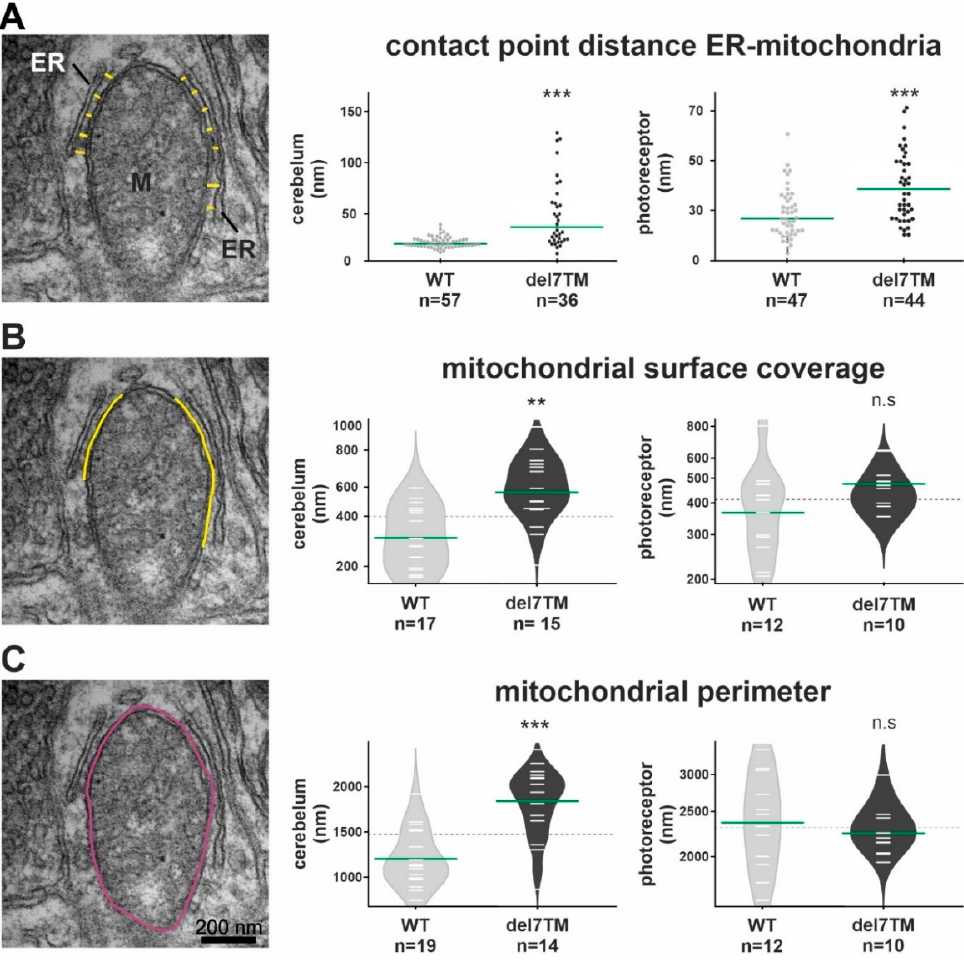
Figure 4. Electron microscopy analysis of the ER-mitochondria interface in murine cerebellum neurons and retinal photoreceptors and S1R abundance at the ER. ( A ) Representative TEM image for the measurement of contact point distance at the ER-mitochondrial interface (WT mice). Mitochondria (M) and the ER (yellow spacer lines) are indicated. Calculation of contact point distance at the ER-mitochondrial interface in WT control and Vlgr1 del7TM cerebellar neurons and photoreceptor cells. ( B ) The mitochondrial surface coverage by ER is indicated by yellow lines in the representative TEM image. Measurements of mitochondrial surface coverage in WT control and Vlgr1 del7TM cerebellum neurons and photoreceptor cells. ( C ) The mitochondrial perimeter indicated in purple in the representative TEM image was measured in WT control and Vlgr1 del7TM cerebellum neurons and photoreceptors. Three independent samples of mature mice of both genotypes and sexes at the age of 4 to 6 months were analyzed. Student’s t-test for statistical significance: ** p < 0.01, *** p < 0.001, n.s. no significance.